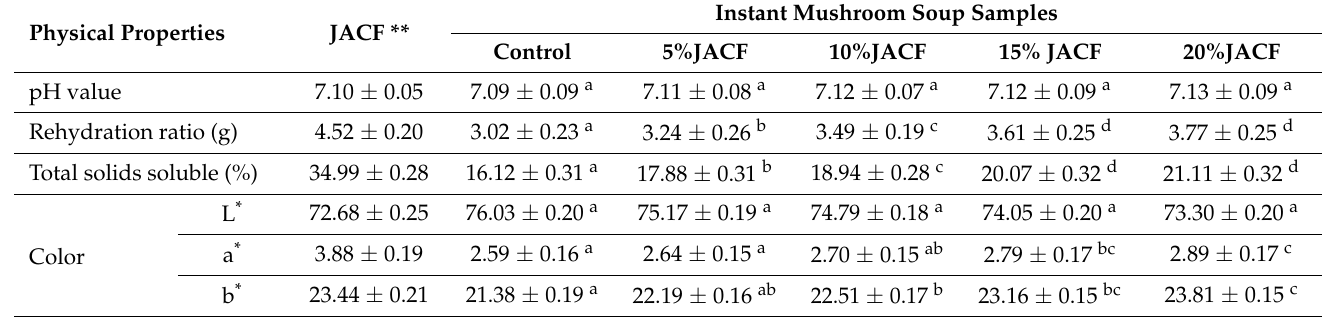
Table 7. Physical properties of the instant mushroom soup